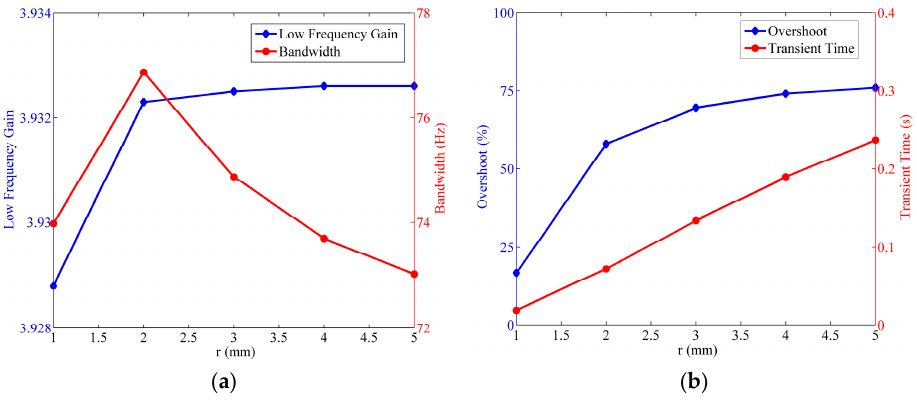
Figure 18. Relationship of the fluidic system indexes versus the cross-section radius of the circular tube, where R h = 2 × 10 10 Ns/m 5 , a = 20 m/s, R = 25 mm. ( a ) Variation of the low frequency gain and the bandwidth; ( b ) variation of the step response overshoot and the transient time.